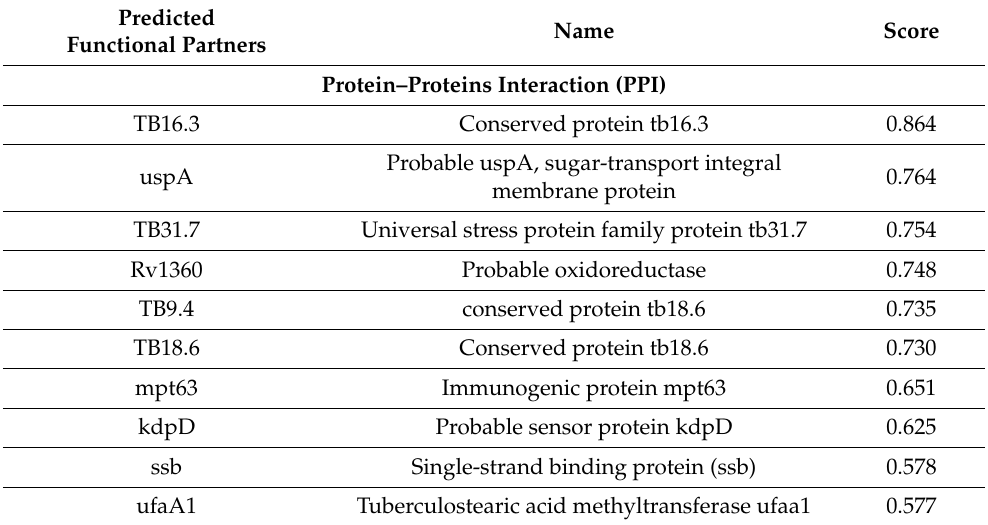
Figure 1. Phylogenetic tree depicting the relationships between Rv1636 protein and M. tuberculosis species. Table 4. Protein–protein and protein–chemical interaction studies of Rv1636